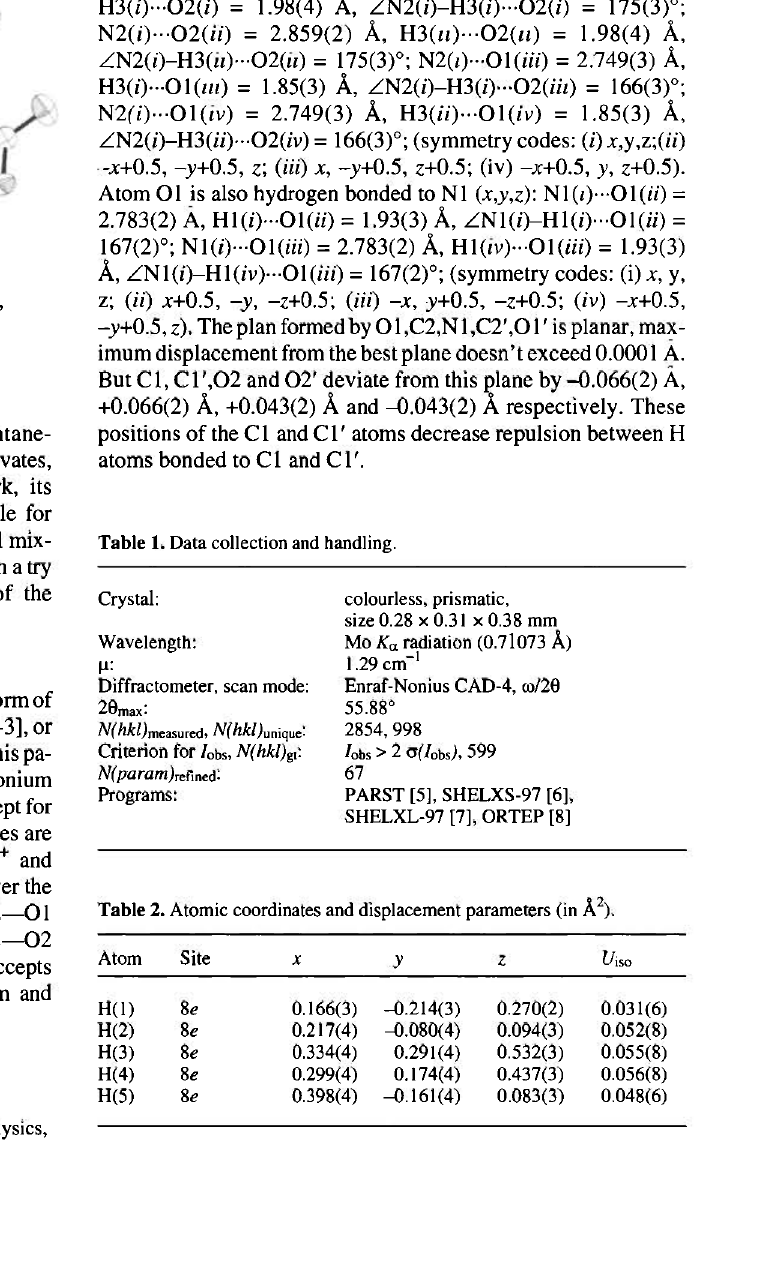
Table 2. Atomic coordinates and displacement parameters (in Ä 2